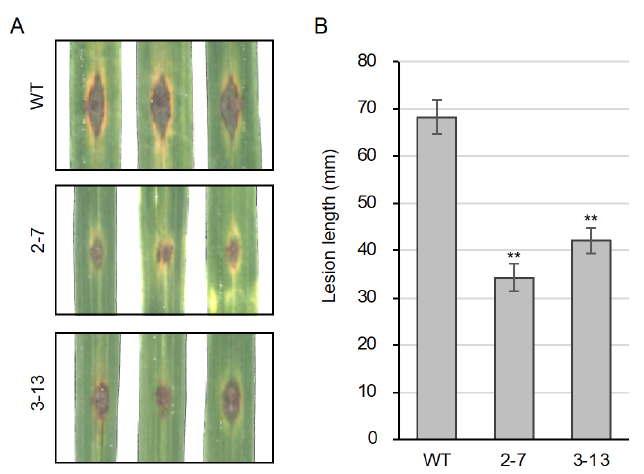
Figure 7. ugt74j1 mutants have increased resistance to rice blast. ( A ) Disease resistance assay using P. oryzae . The fifth leaves of the wild type and the ugt74j1 mutants were inoculated with a spore suspension. After 5-d incubation, lesion length was imaged. ( B ) Quantification of the lengths of the lesions shown in ( A ). The data are represented as the mean ± SE ( n = 24). Asterisks indicate statistically significant differences compared with the wild type ( t -test, p <